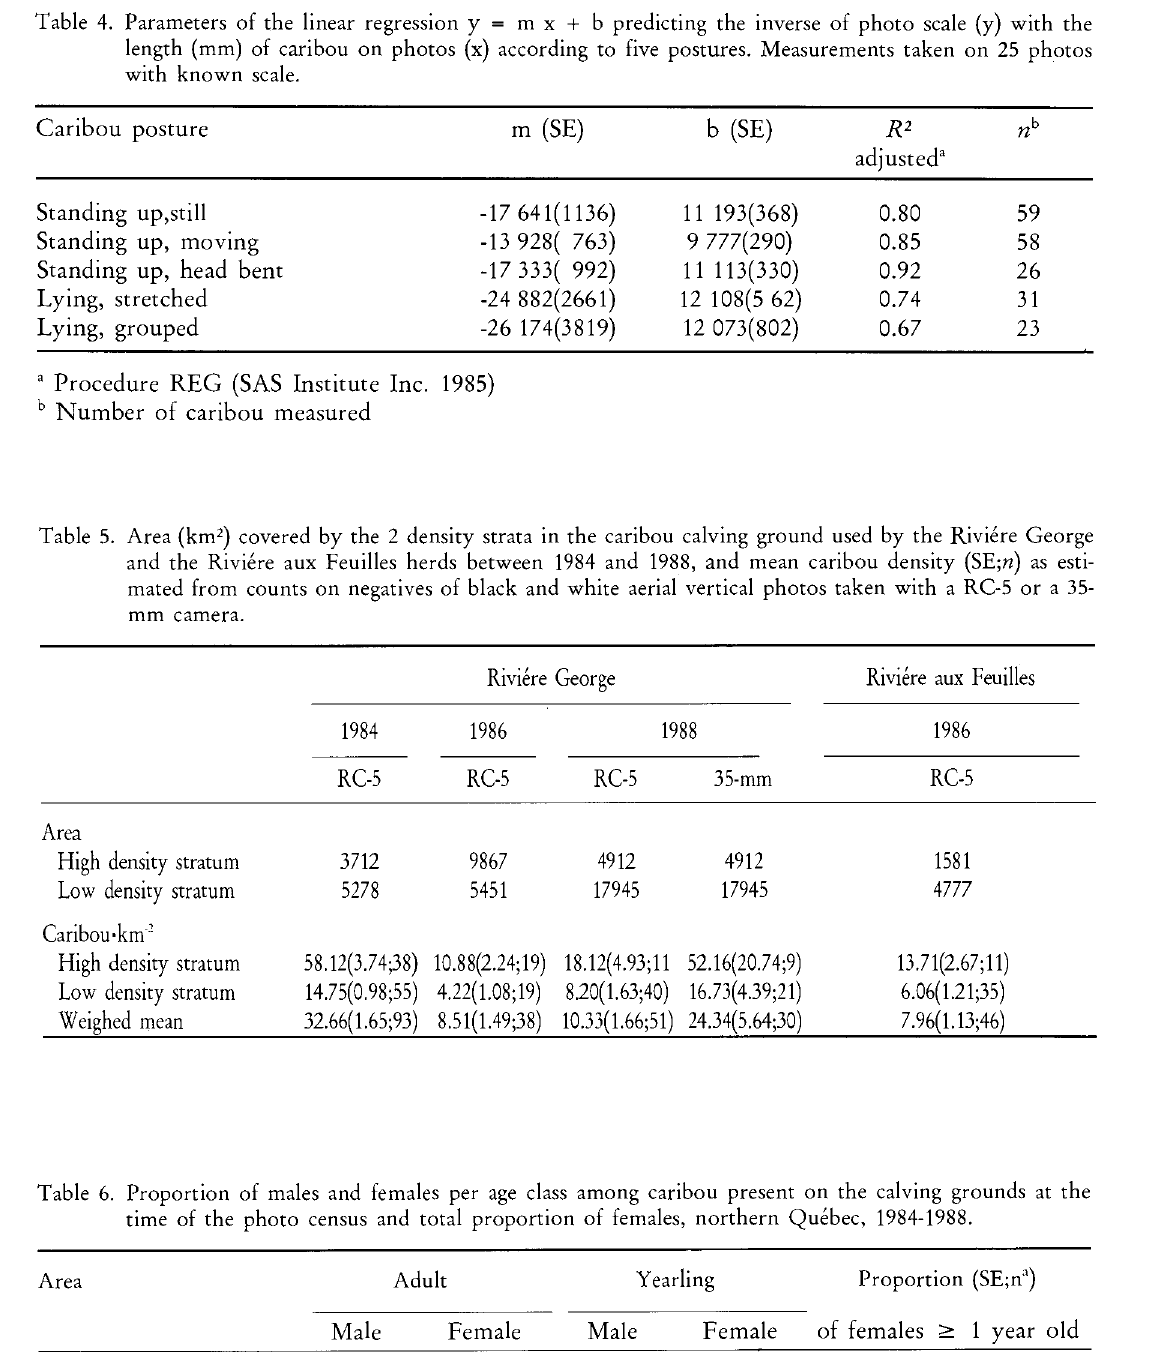
Table 6. Proportion of males and females per age class among caribou present on the calving grounds at the time of the photo census and total proportion of females, northern Quebec, 1984-1988.